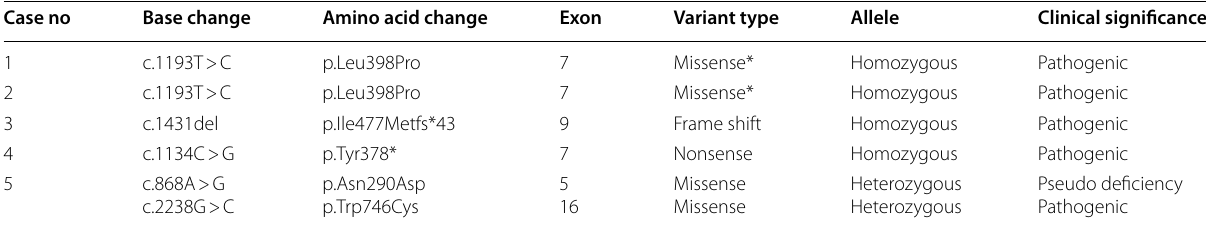
Table 3 Mutations identified in the enrolled subjects: